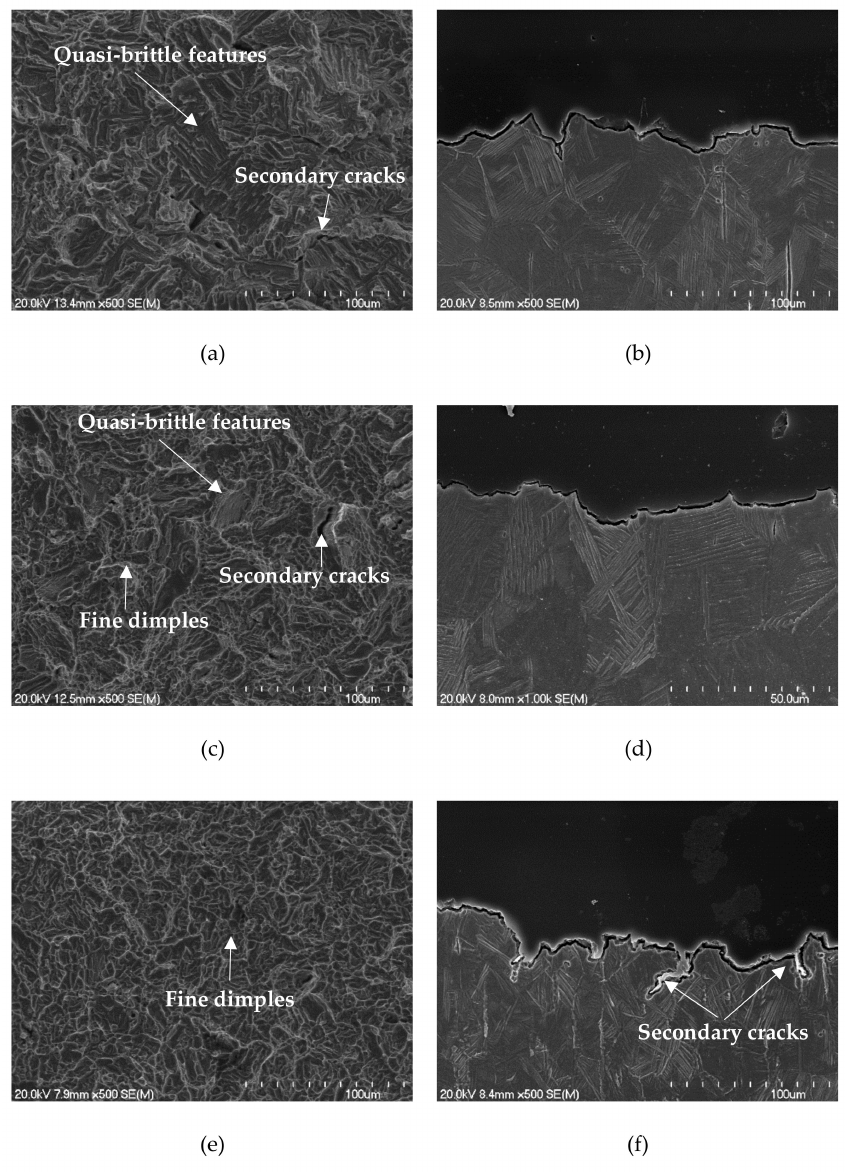
Figure 5. Fracture surfaces ( a , c , e ) and cross-sections ( b , d , f ) of the PM Ti-5Fe alloys extruded at di ff erent temperatures: ( a , b ) 900 ◦ C, ( c , d ) 850 ◦ C, and ( e , f ) 800 ◦